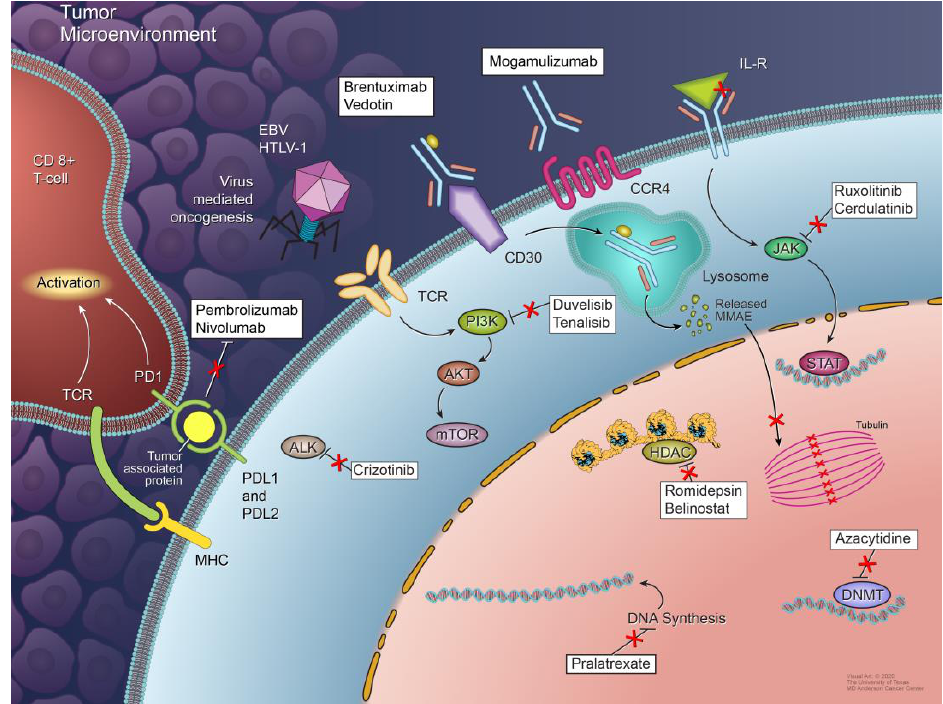
Figure 1. Mechanisms of peripheral T-cell lymphoma development and agents used for targeted therapies. Multiple mechanisms are responsible for the development and proliferation of different subtypes of PTCL, including signaling pathway deregulation, epigenetic dysregulation, tumor microenvironment signals, and virus-mediated oncogenesis. Not all of these mechanisms are involved in the pathogenesis of each PTCL subtype. Some potential therapeutic targets and agents targeting them are also shown.